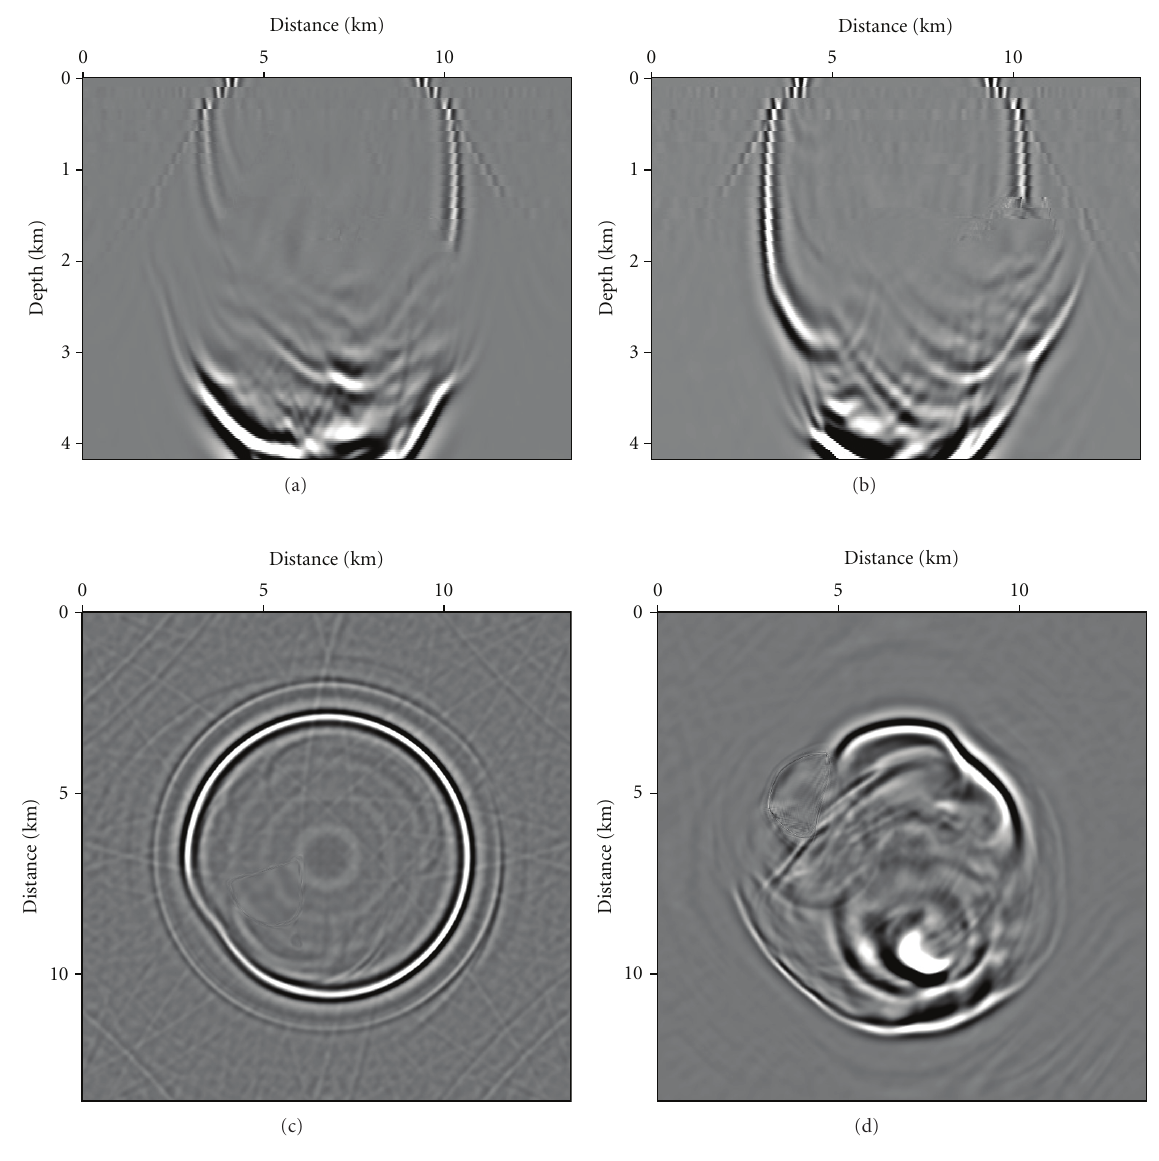
Figure 5: Impulse response obtained by FD migration using the complex Pad´e approximation with 1 term with rotation angle of 15 ◦ and Li correction (cross-sections as